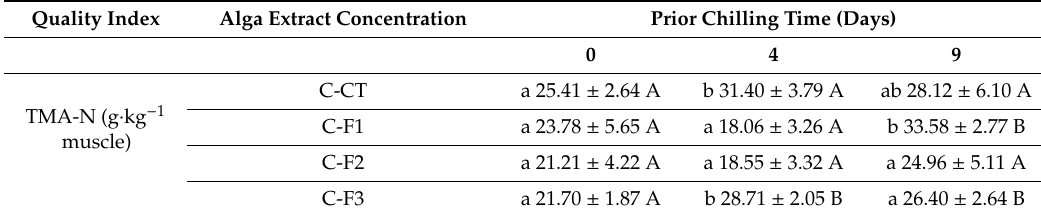
Table 2. Determination of trimethylamine-nitrogen (TMA-N) content in canned mackerel packaged with di ff erent alga extract concentrations and previously subjected to di ff erent chilling